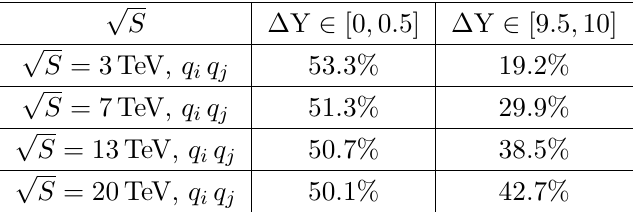
Table 7 . Flavour composition of the dPDFs belonging to the same proton and contributing to